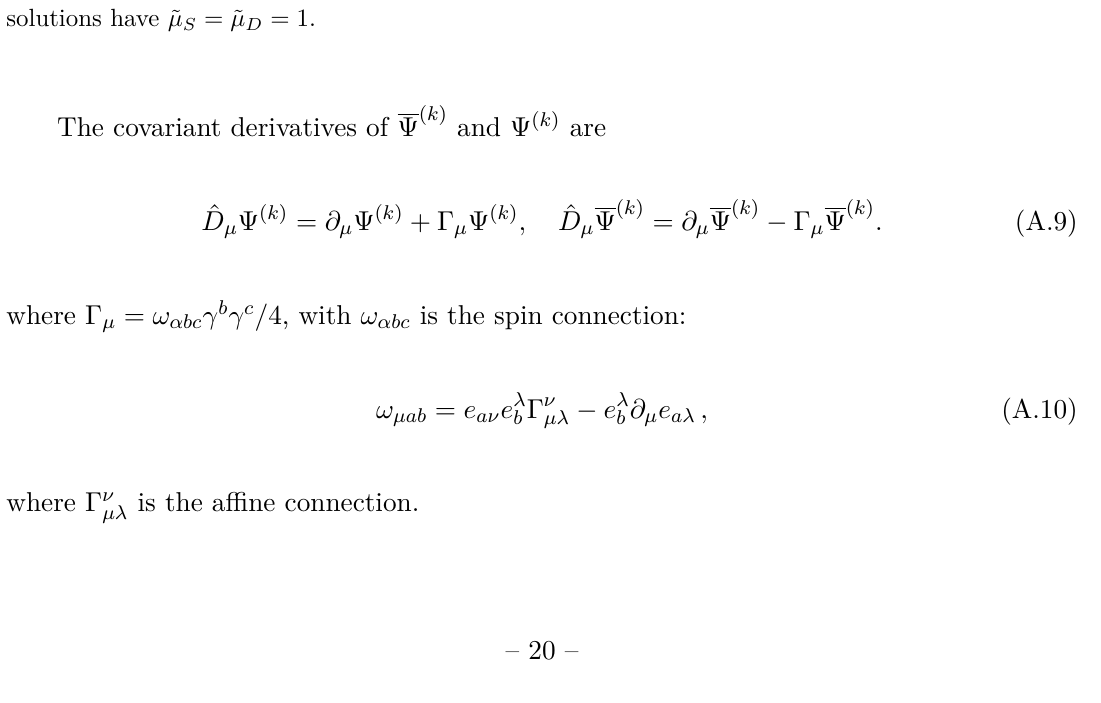
Table 3. Maximum and minimum ADM masses ( M max and M min ) of the DBSs, and the existence domain of the nonsynchronized frequency ˜ ω D for ˜ ω S = 0 . 7675 , 0 . 749 , 0 . 731 , 0 . 7128 . B 1 , B 2 and B 3 represent the first, second and third branches of the orange line in figure 8, respectively. All solutions have ˜ µ S = ˜ µ D = 1